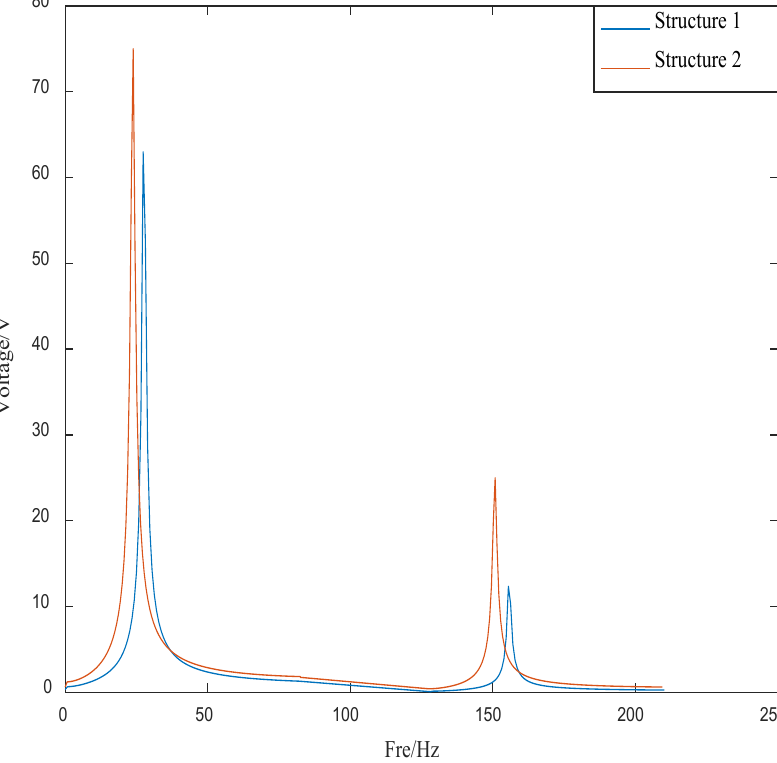
Figure 13. The control voltage of structure 1 and structure 2 after FFT conversion. As can be seen from Figure 13, the control voltage of the first-order mode of structure 1 is 63V and the control voltage of the second-order mode of is 12V. The control voltage of the first-order mode of structure 2 is 75V and the control voltage of the second-order mode is 26V. The overall control voltage of structure 1 is less than structure 2, which sat- isfies the above theory.